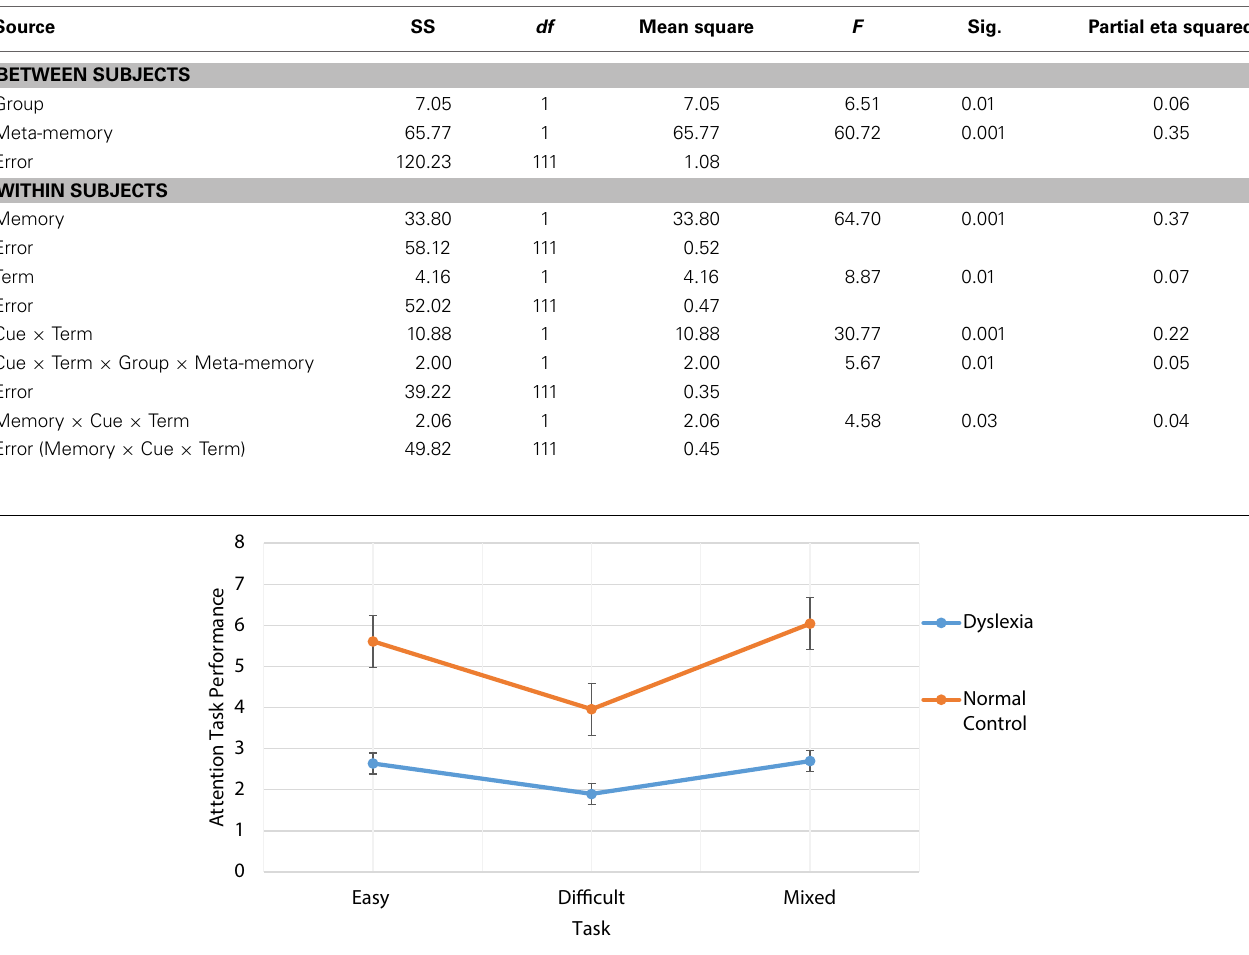
Table 2 | Summary of analysis of variance of performance scores on group (Dyslexi vs. Normal control), Meta-memory (Low vs. High), Memory (Prospective vs. Retrosective), Term (Short vs. Long), and Cue (Self vs. Environment).